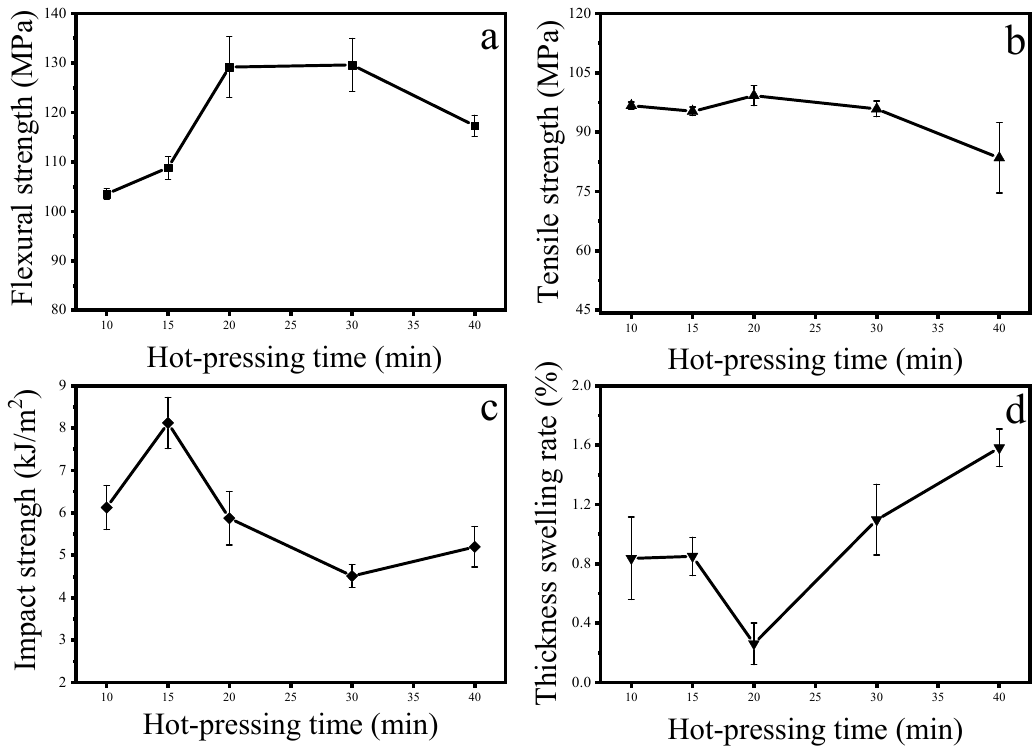
Figure 2. Effect of hot-pressing time on the performance of composite panels: ( a ) flexural strength; ( b ) tensile strength; ( c ) impact strength; ( d ) thickness swelling rate.